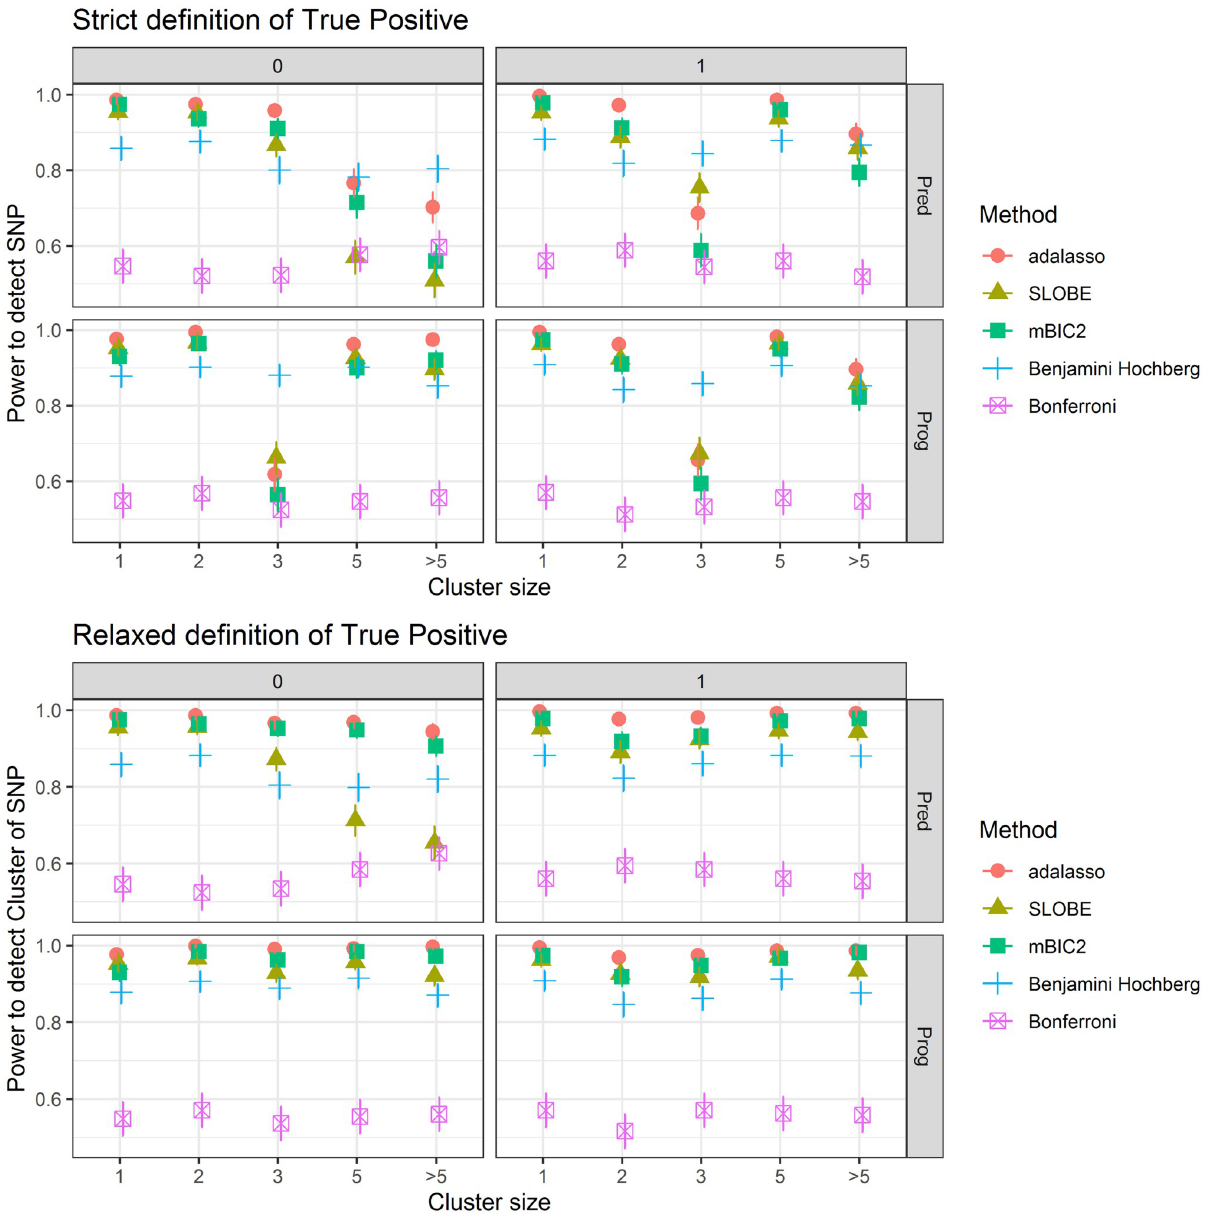
Fig 4. Power to detect individual SNPs. SNPs are arranged according to three different criteria. The rows of the facets indicate whether SNPs are predictive (first row) or prognostic (second row), The columns of the factets indicate whether they are specifically of one type (left column) or both predictive and prognostic (right column). Within each facet SNPs which belong to larger clusters are found further to the right. The first plot is based on a strict definition of true positives where the detected SNP must coincide with the SNP from the data generating model. The second plot uses the more relaxed definition where a detected SNP is counted as true positive whenever it is within the same cluster as a SNP from the data generating